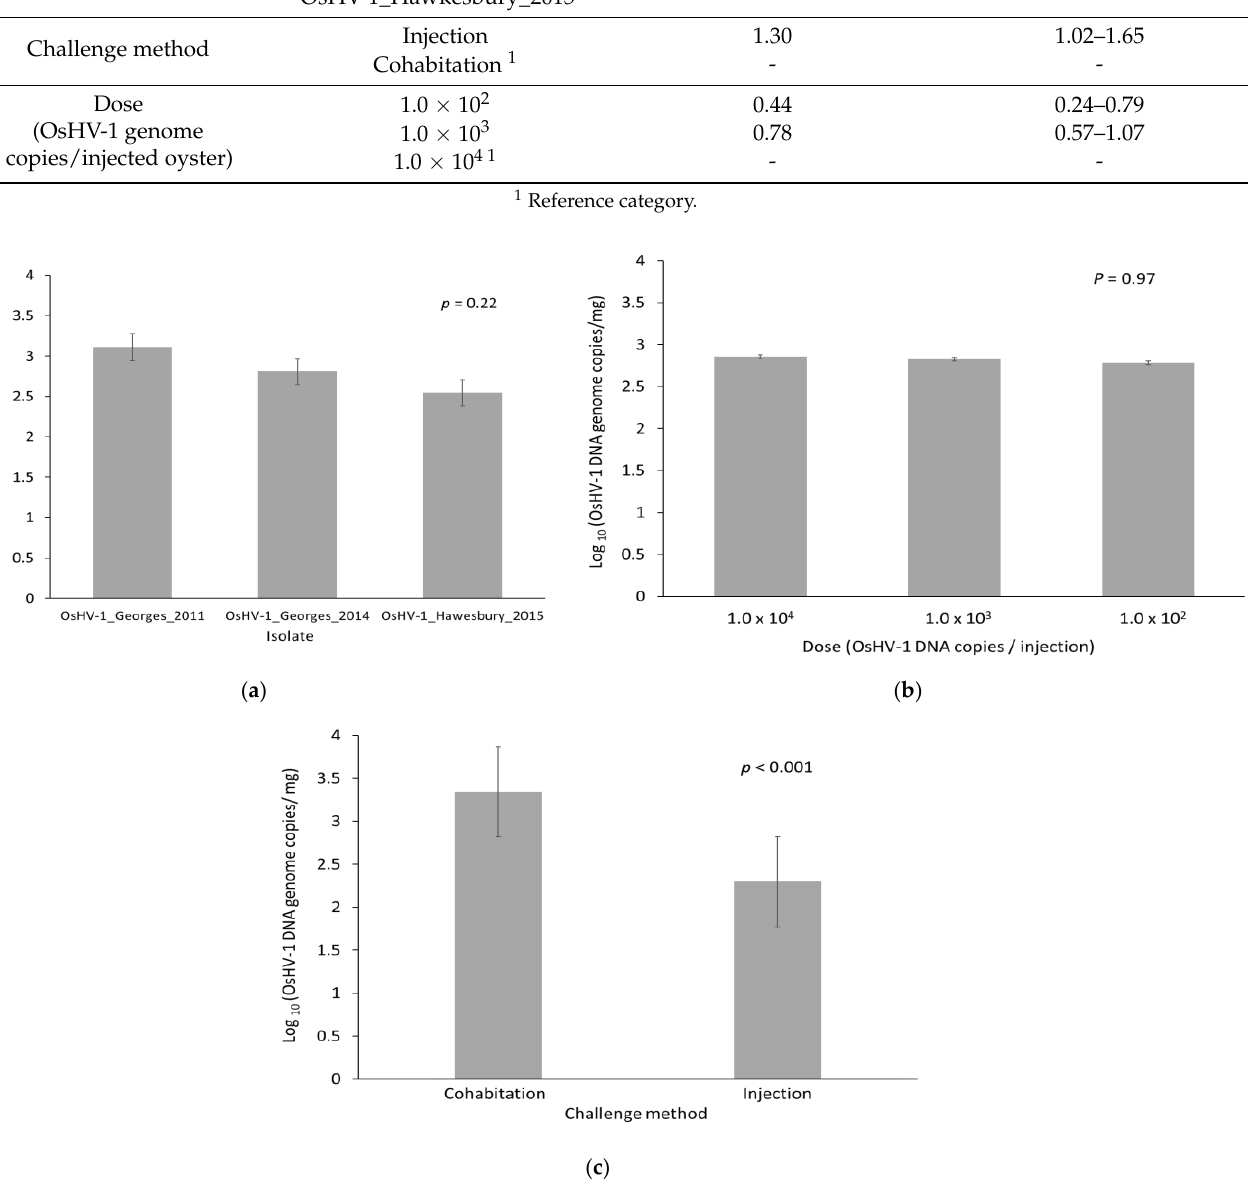
Figure 3. Estimated quantity of OsHV-1 DNA at the time of death in oysters that died following challenge by injection or cohabitation. ( a ) OsHV-1 isolate; ( b ) Dose of OsHV-1 for oysters that were challenged by injection; ( c ) Challenge method. Data are the predicted mean and standard error from a general linear model.